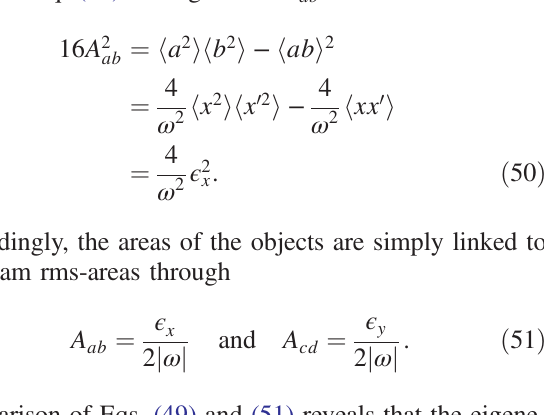
ffiffiffiffiffiffiffiffiffiffiffiffiffiffiffiffiffiffiffiffiffiffiffiffiffiffiffiffiffiffiffiffi p h x 2 ih y 2 i − h xy i 2